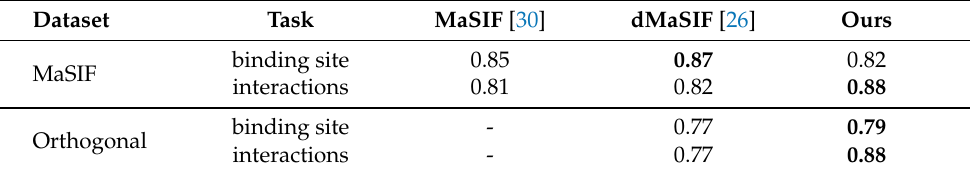
Table 2. Evaluation of PPI prediction models. The models’ AUROC scores were evaluated on the test set of the MaSIF dataset and on the test set of our new Orthogonal dataset for the two tasks of binding site and interaction prediction Table 1. There we made sure that the ratio of the test data to training data is very high, hence evaluating test set is likely to be a more accurate and reliable indicator of the generalization capabilities. While our model does not significantly improve the results of dMaSIF [26] on the MaSIF dataset (with better results for interaction prediction but inferior results for binding site prediction), it significantly outperforms dMaSIF on the new Orthogonal dataset, which better captures the diversity of possible protein binding pairs. The results that we obtained using dMaSIF model used the default configuration (three layers, patch size 12 Å) of the model. No modifications of the dMaSIF code or model were made. For exemplary confusion matrices using a threshold of 0.5, see Tables A1–A4 in Appendix A. Additionally, in the same Appendix, we detailed the analysis on how much the accuracy of each model is above the corresponding random accuracy, as described in [53,54]. Finally, bolded values in this table are the superior AUROC (area under the receiver operating characteristic curve) values. These AUROC values are summarized predictions across different surface patches, explanation on calculating the same can be found in Section